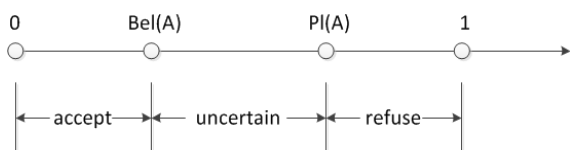
Figure 5. Belief